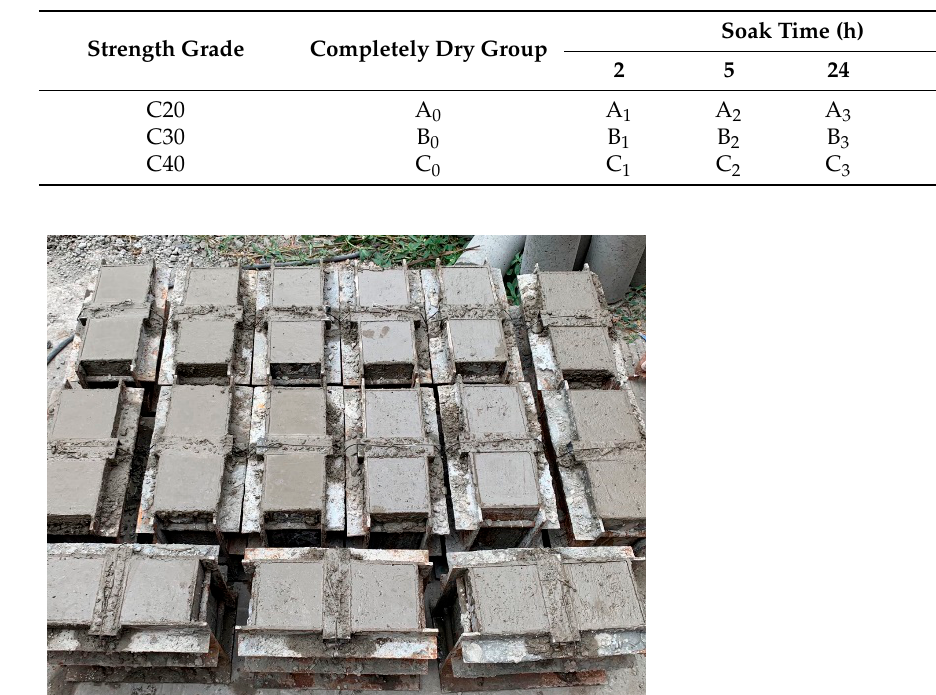
Table 2. Experimental grouping.